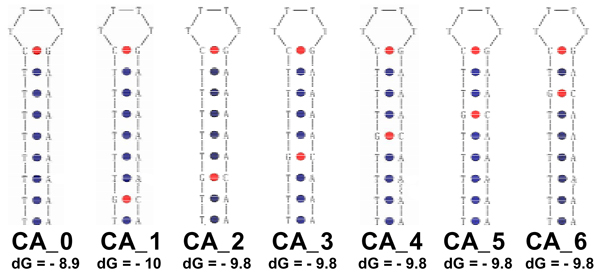
In preliminary nanopore studies the wild-type 3' end sequence (-C-A-T-G-3') was found to be similar to (-C-A-A-A-3'), which motivated the present study of a group of DNA hairpins consisting of all adenosines on the 3' side of the molecule, except for one cytosine-adenosine step. Contrary to the differences (seemingly) indicated by nature, the calculated ΔG° of hairpin formation (using MFold [54]) is the same for the set of molecules described, with one CA step (the CA set).